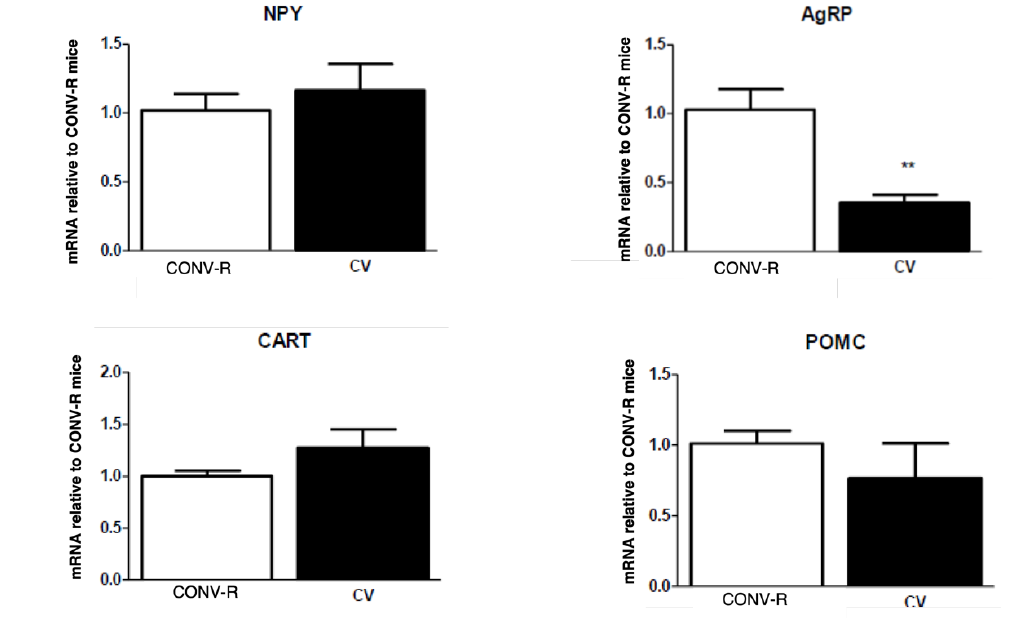
Figure 6. qPCR of hypothalamic peptides in 10 days conventionalized (CV) vs. CONV-R. mRNA expression levels of CV mice are relative to the mean level of CONV-R counterparts. Data are expressed as means ± SEM. ** denotes statistical difference between GF and CONV-R. ** p < 0.01.